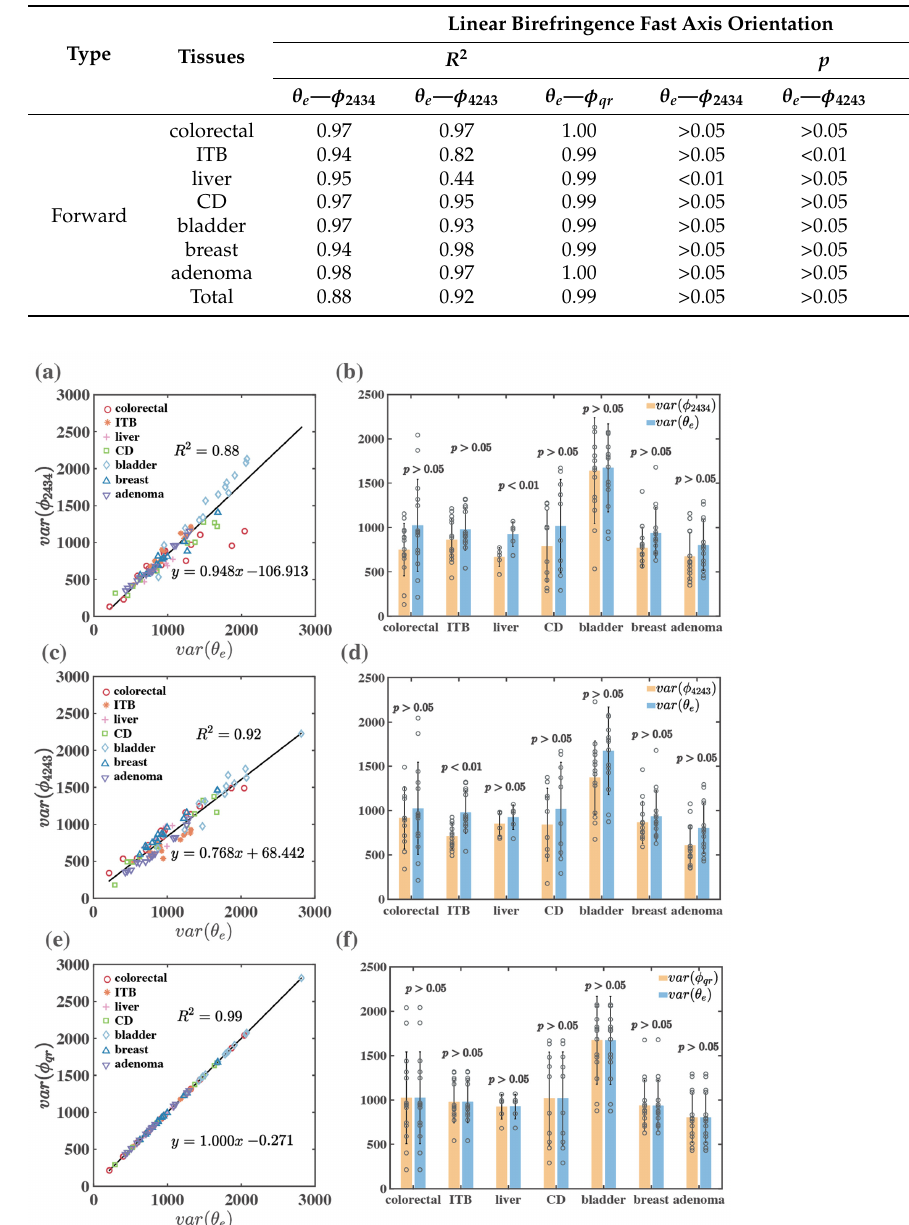
Figure 5. Comparison of linear birefringence fast axis orientation MMT and MMPD parameters of thin tissue samples. ( a ) Variance of linear birefringence orientation MMPD parameter θ e plotted against its counterpart MMT parameter ϕ 2434 for correlation analysis with all seven kinds of thin tissue samples. ( b ) Statistical analysis bar chart of linear birefringence orientation MMPD parameter θ e and MMT parameter ϕ 2434 for each kind of thin tissue samples. ( c ) Variance of linear birefringence orientation MMPD parameter θ e plotted against its counterpart MMT parameter ϕ 4243 for correlation analysis with all seven kinds of thin tissue samples. ( d ) Statistical analysis bar chart of linear birefringence orientation MMPD parameter θ e and MMT parameter ϕ 4243 for each kind of thin tissue samples. ( e ) Variance of linear birefringence orientation MMPD parameters θ e plotted against its counterpart MMT parameter ϕ qr for correlation analysis with all seven kinds of thin tissue samples. ( f ) Statistical analysis bar chart of linear birefringence orientation MMPD parameter θ e and MMT parameter ϕ qr for each kind of thin tissue sample.